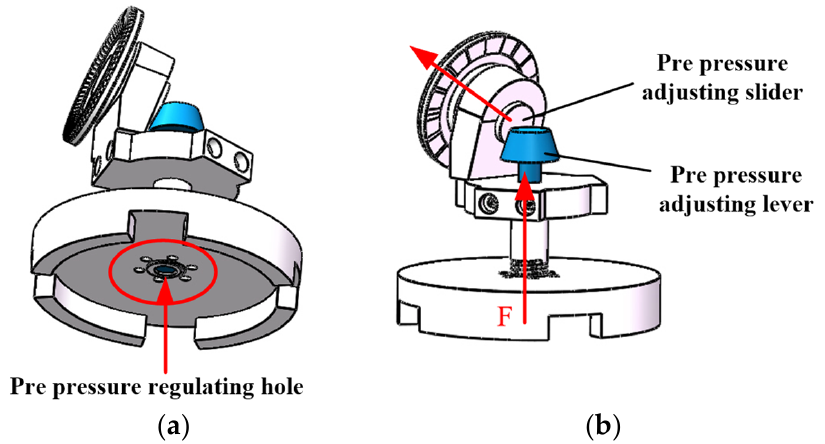
Figure 2. Pre pressure regulating system: ( a ) Bottom of the base; ( b ) Inside of the